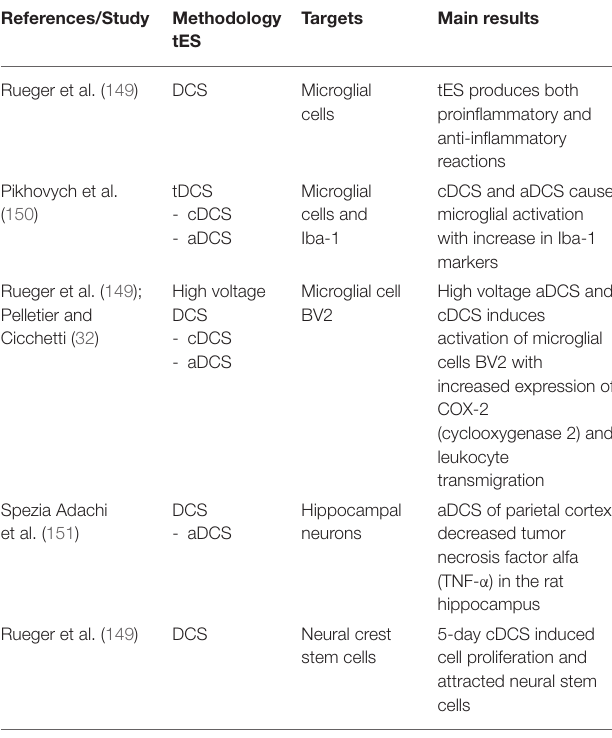
TABLE 5 | tES after-effects on glial cells and